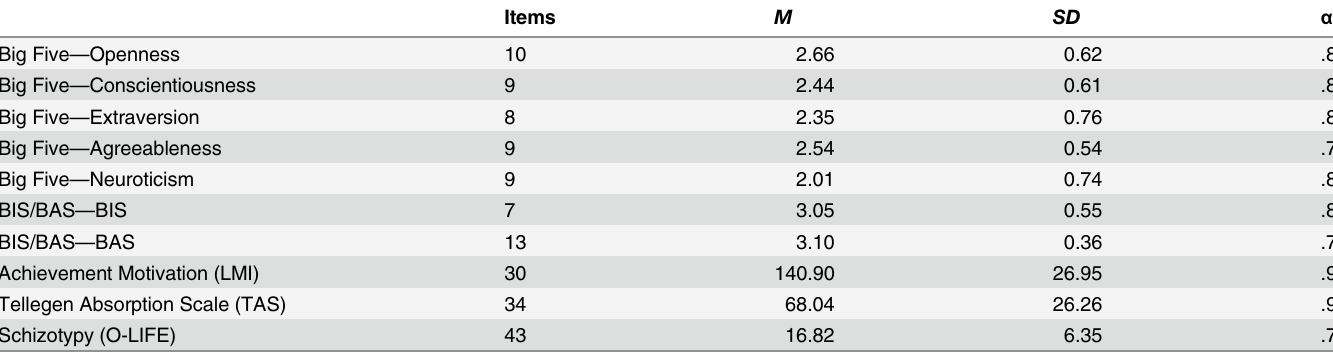
Table 1. Descriptive data and consistency of the personality scale.